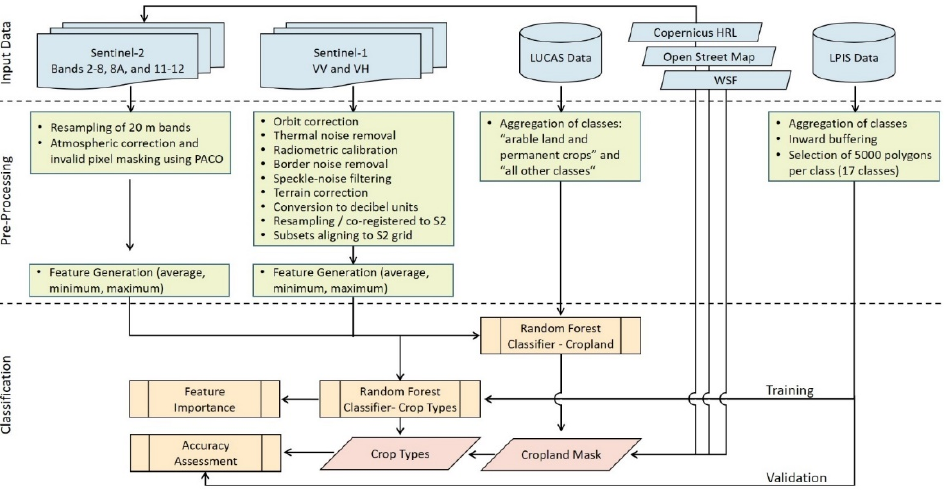
Figure 1. Workflow for the crop type classification in Germany for the year 2018 based on multispectral Sentinel-2, SAR Sentinel-1, LPIS, LUCAS, and auxiliary data.